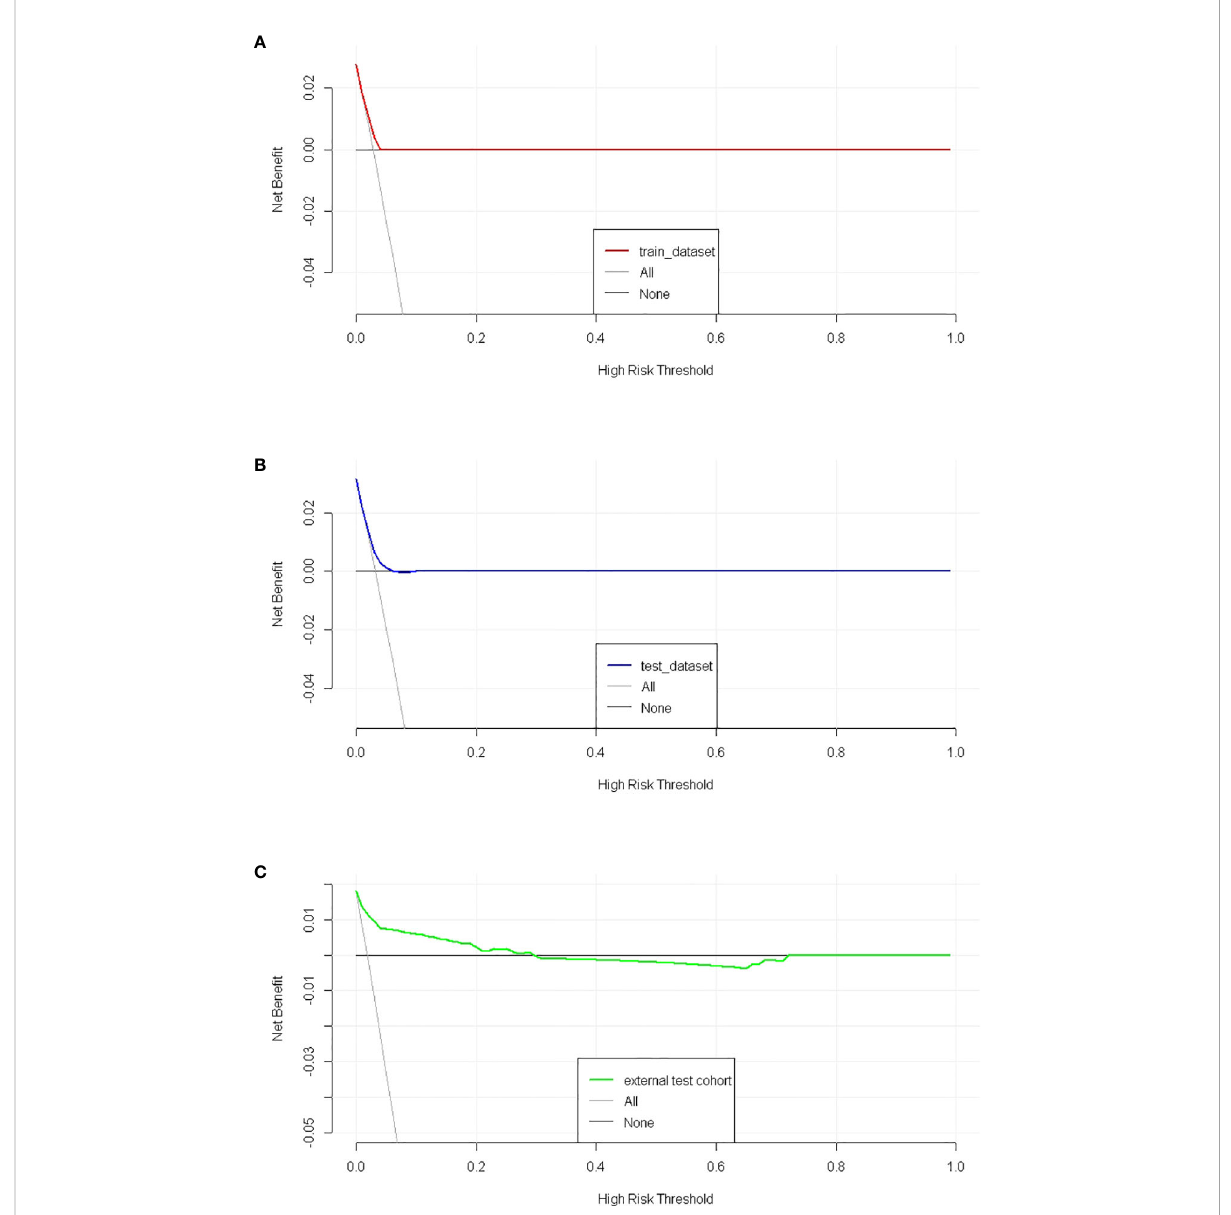
FIGURE 6 The decision curves of SPM risk prediction nomogram. (A) trainset; (B) testset; (C) external test